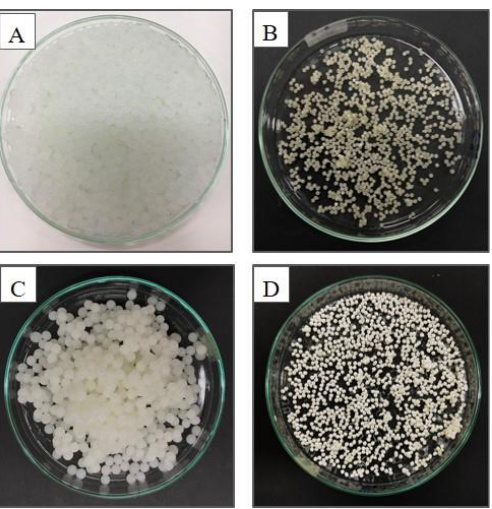
Figure 1. Photographs of wet and dry ( A , B ) PHBs and ( C , D ) s-PHBs, respectively.